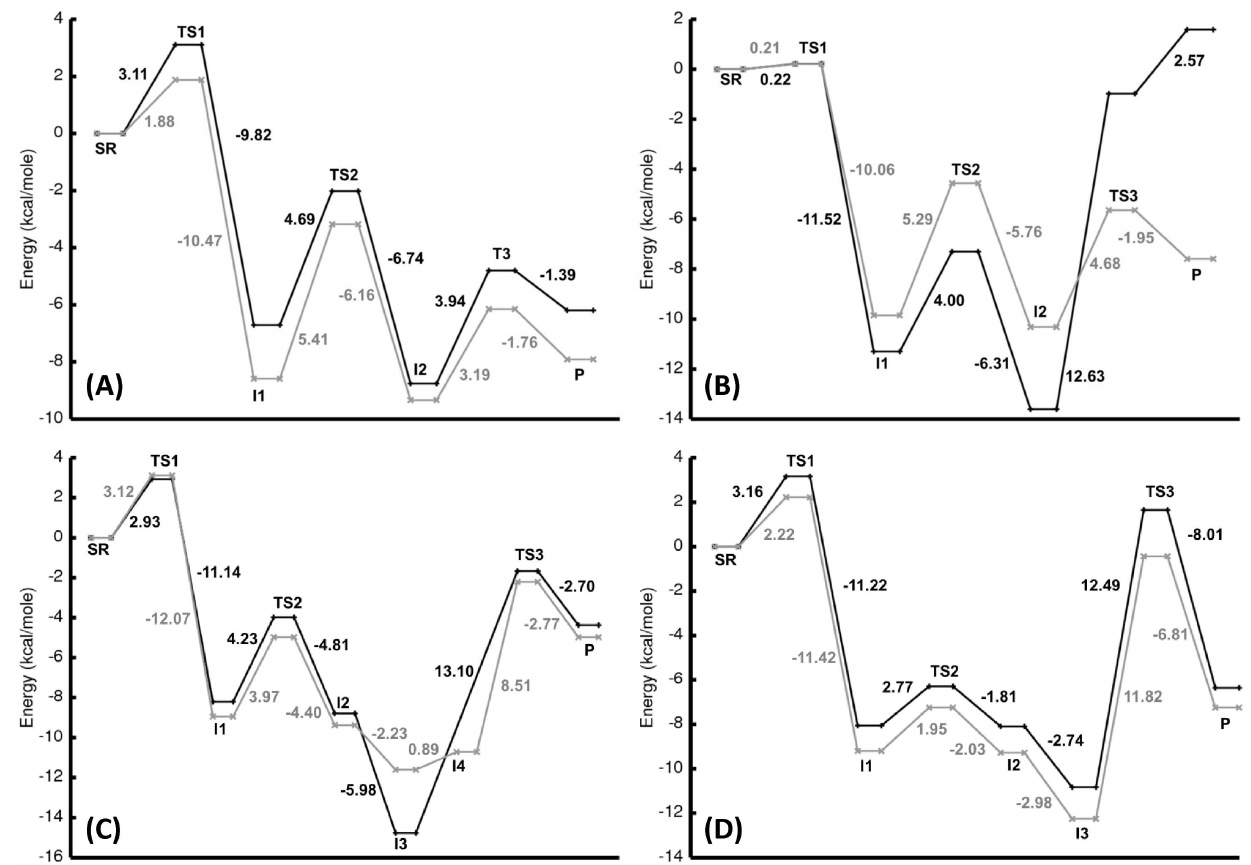
Figure 9. Relative energies to the separated reactants from single point solvation (CPCM) calculations using the gas-phase stationary points for the zinc (black) and cobalt (gray) complexes are shown for N3 (A), N4 (B), Ph (C), and Ben (D).